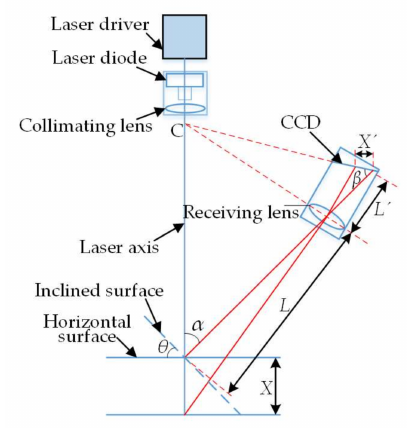
Figure 4. Schematic of laser